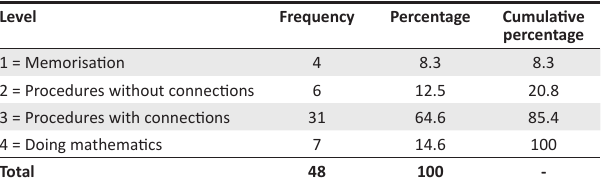
TABLE 3: Frequency table of the mean cognitive demand ratings of probability and counting principles learning tasks. Level Frequency Percentage Cumulative